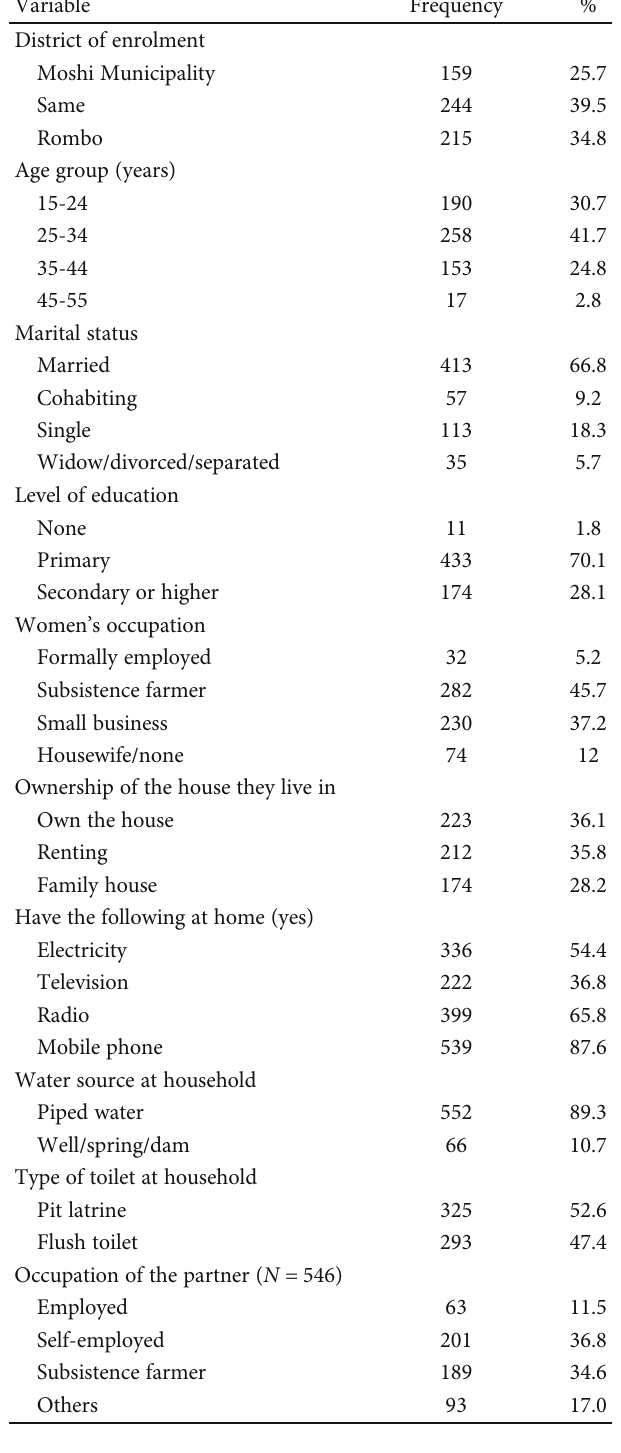
Table 1: Baseline characteristics of the participants ( N = 618